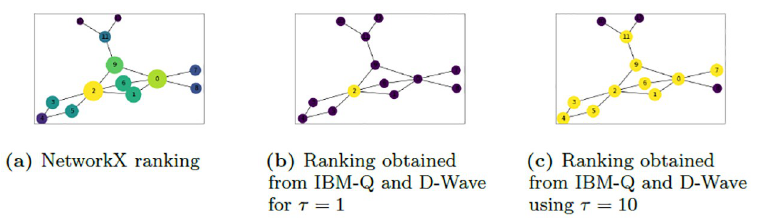
Fig 7. Results for graph M . The graph M showing the most central nodes using (a) the NetworkX EC algorithm, and ((b) and (C)) QUBO on the IBM-Q and D-Wave quantum computers for (b) τ = 1 and (c) τ = 10 with P = 5 n where n is the number of nodes of the graphs. For (a), the most central node(s) is(are) of brighter colors and are encircled by larger circles. In (b) and (c), the bright colored (yellow) nodes are the most central nodes whiles the dark colored (purple) nodes are the least central nodes relative to τ .